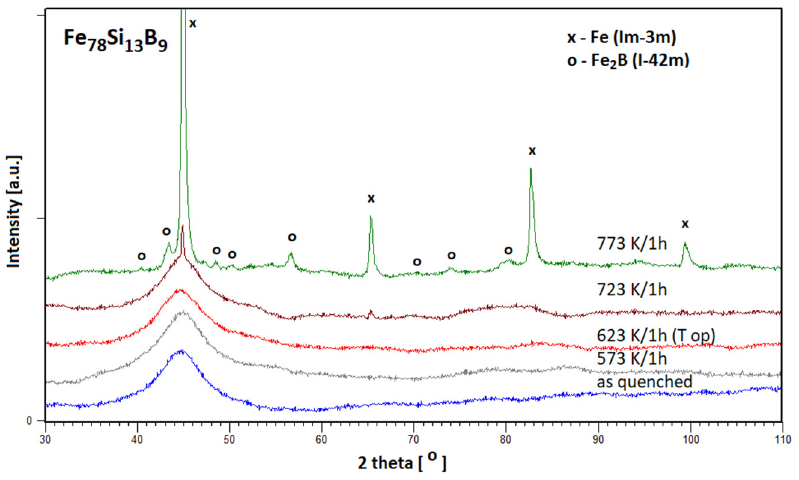
Figure 2. The X-ray diffraction patterns obtained for investigated alloys as-quenched and annealed at T a = 573 K/1 h, T a = T op = 623 K/1 h, T a = 723 K/1 h and at T a = 773 K/1 h.